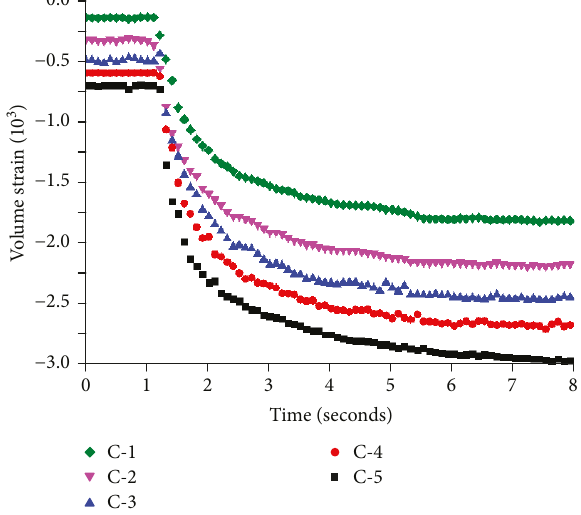
Figure 8: Volumetric strain as a function of time at sudden unloading of